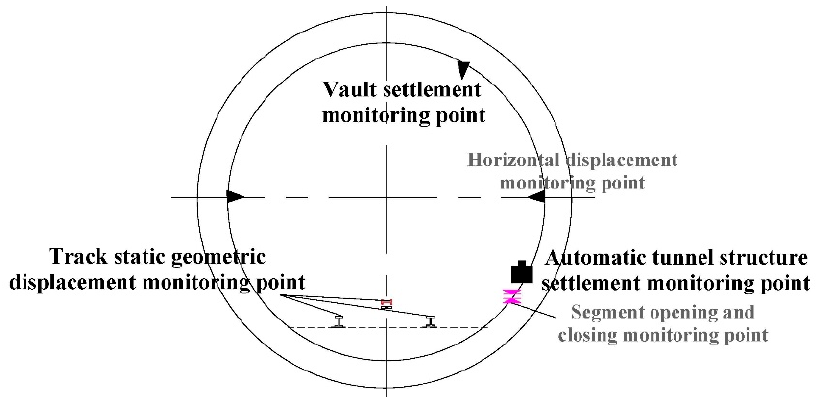
Figure 10. Layout of the monitoring points of the existing tunnel.